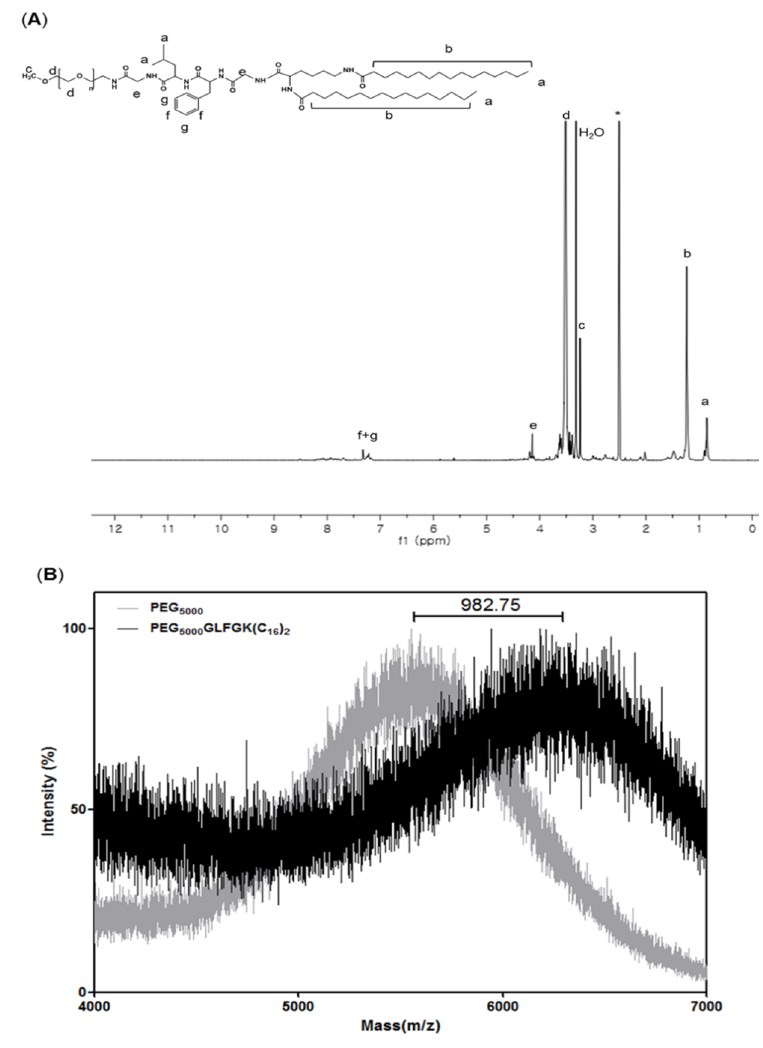
Figure 3. Measurements of PEG-GLFG using 1 H-NMR and MALDI TOF mass spectroscopy. ( A ) 1 H-NMR spectroscopy in DMSO-d 6 , ( B ) MALDI-TOF mass spectroscopy. 2,5-Dihydroxybenzoic acid (DHB) was used as a matrix.